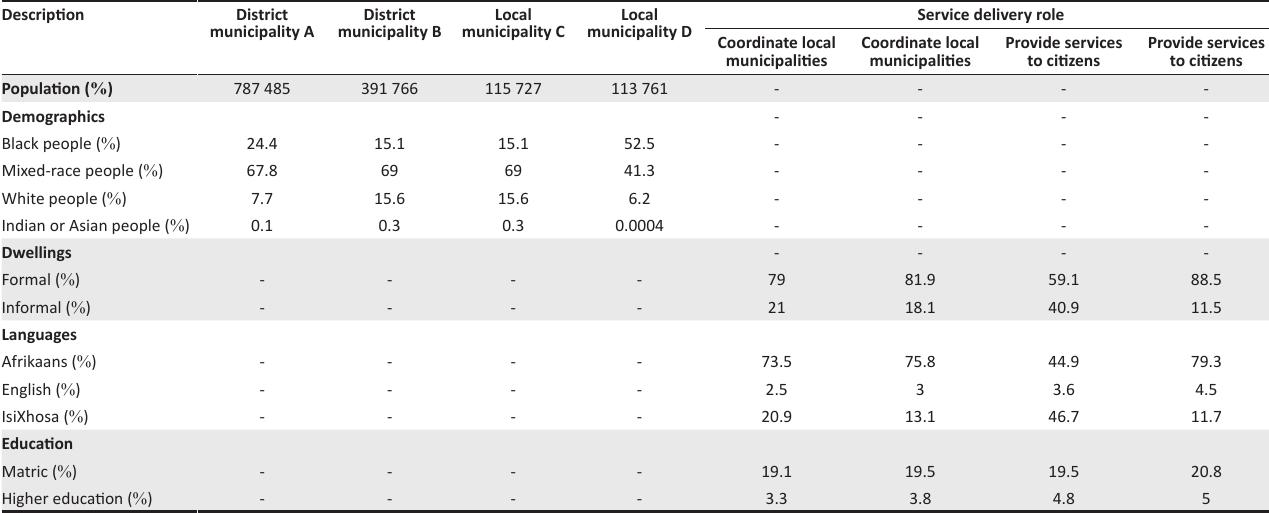
TABLE 2: Description of municipalities participated in the study.